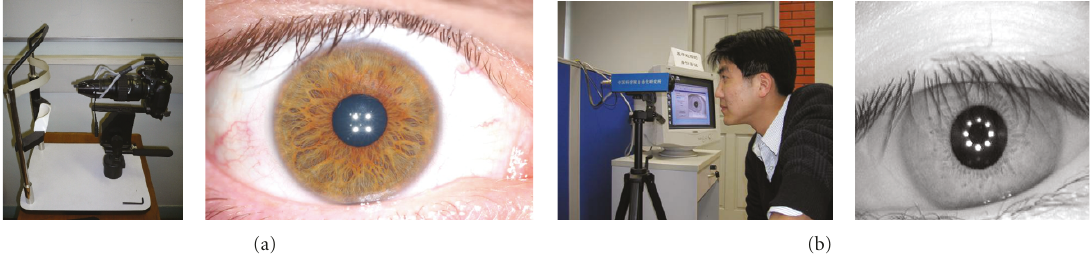
Figure 1: Acquisition systems and iris images from (a) ISEP database and (b) CASIA